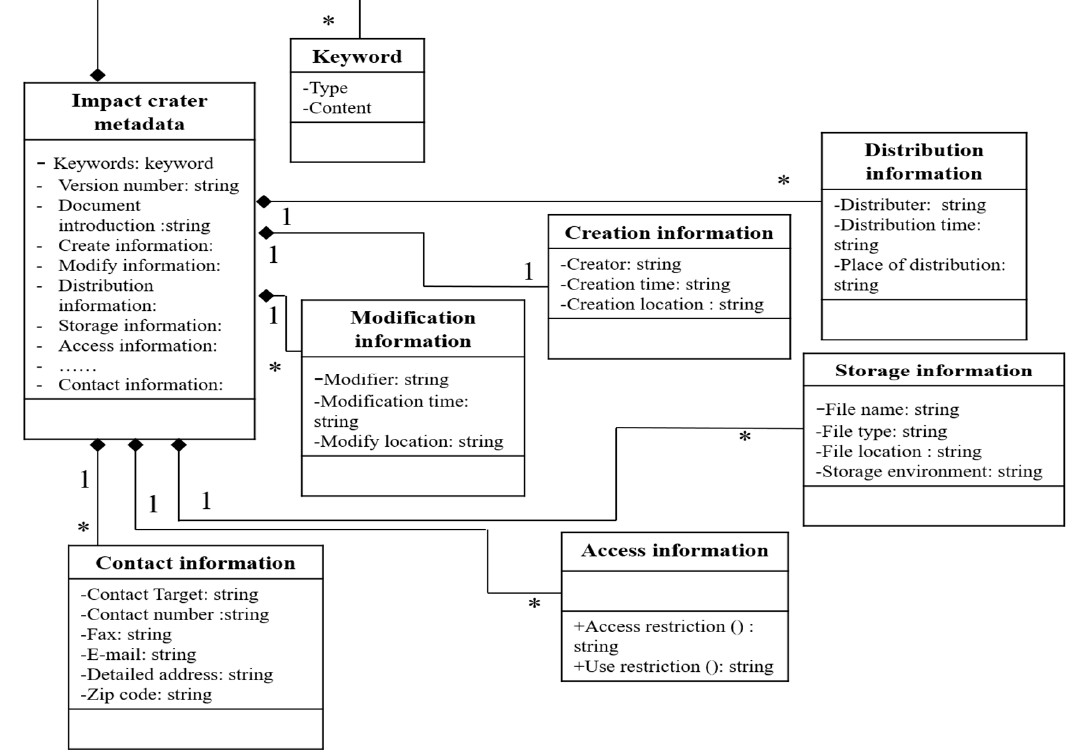
Figure 13. UML for the metadata organisation of descriptive indices.